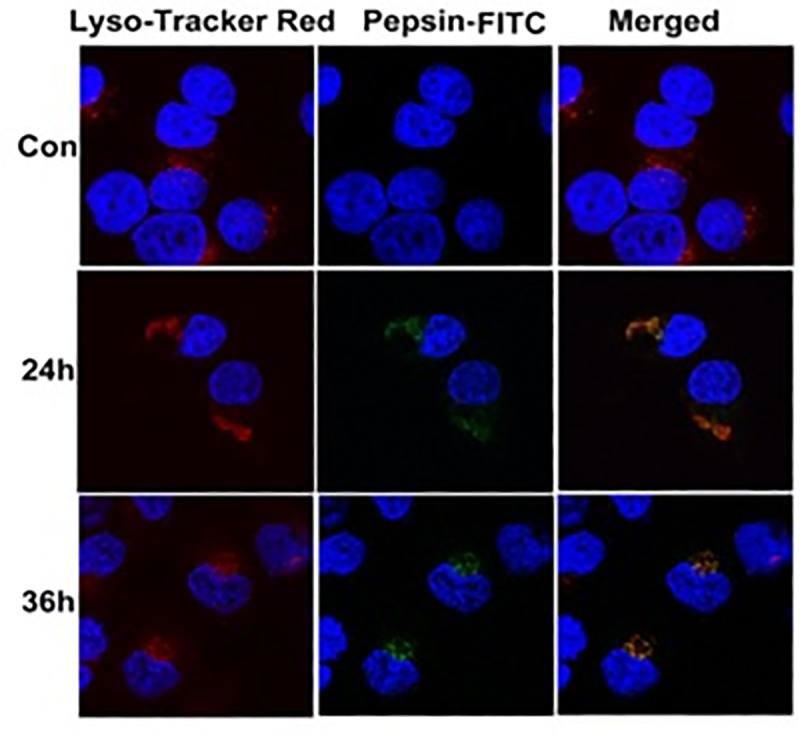
Localization of pepsin to the lysosomes of FaDu.FaDu cells were treated with Pepsin-Cy3 for 0.5 h, washed and incubated for 24 hours or 36 hours. After labeling with Lyso-tracker red, cells were stained with DAPI and visualized under a confocal microscope. Pepsin taken up by cells mainly localized to the lysosomes at 36 hours post-treatment.